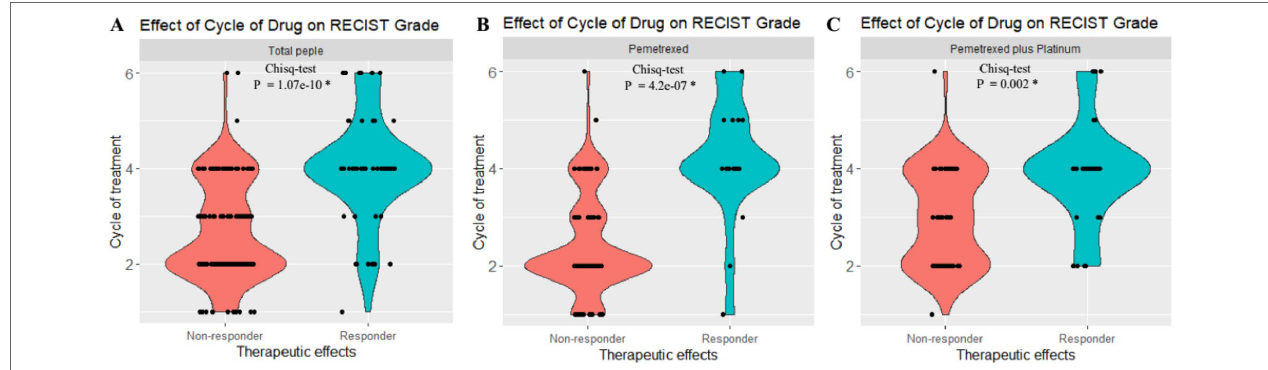
cycle of chemotreatment, and 2, 4, and 6, respectively, refer to 2, 4, and 6 cycles of chemotreatment. The x axis indicates the therapeutic effects of treatment with pemetrexed-based